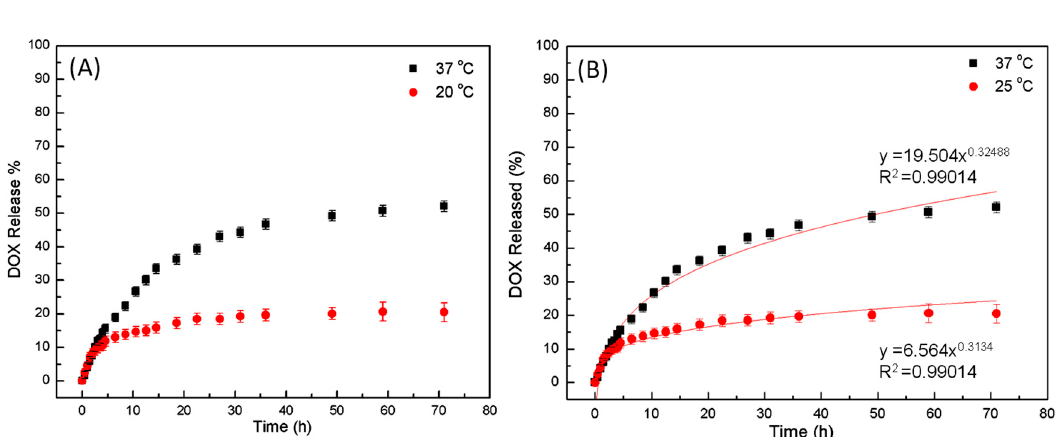
Figure 7. ( A ) Release profiles of DOX from LCHBPNIPAM self-assemblies as a function of time at 20 °C (red line) and 37 °C (black line); and ( B ) the profile of drug release mechanism based on the Higuchi kinetics and the Korsmeyer–Peppas semi-empirical equation under 20 and 37 °C.